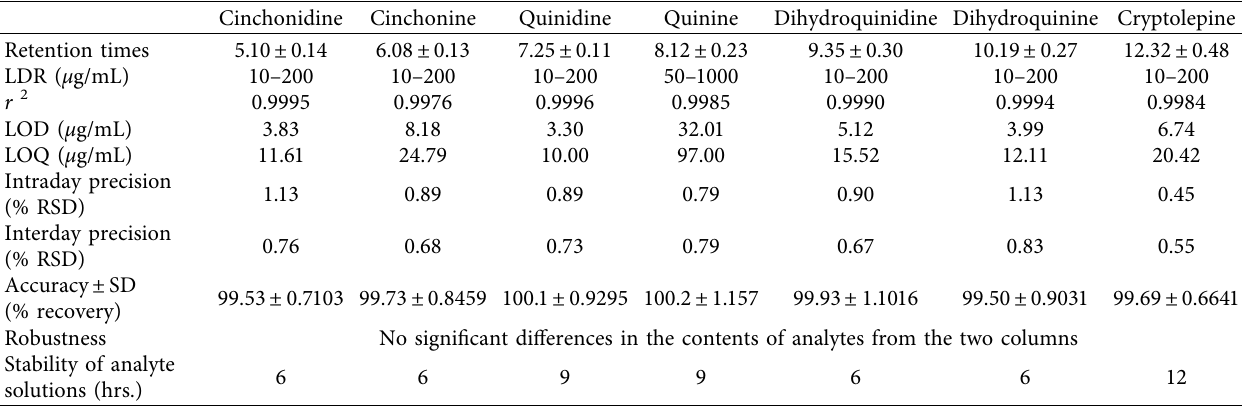
Table 1: Summary of validation results for the developed